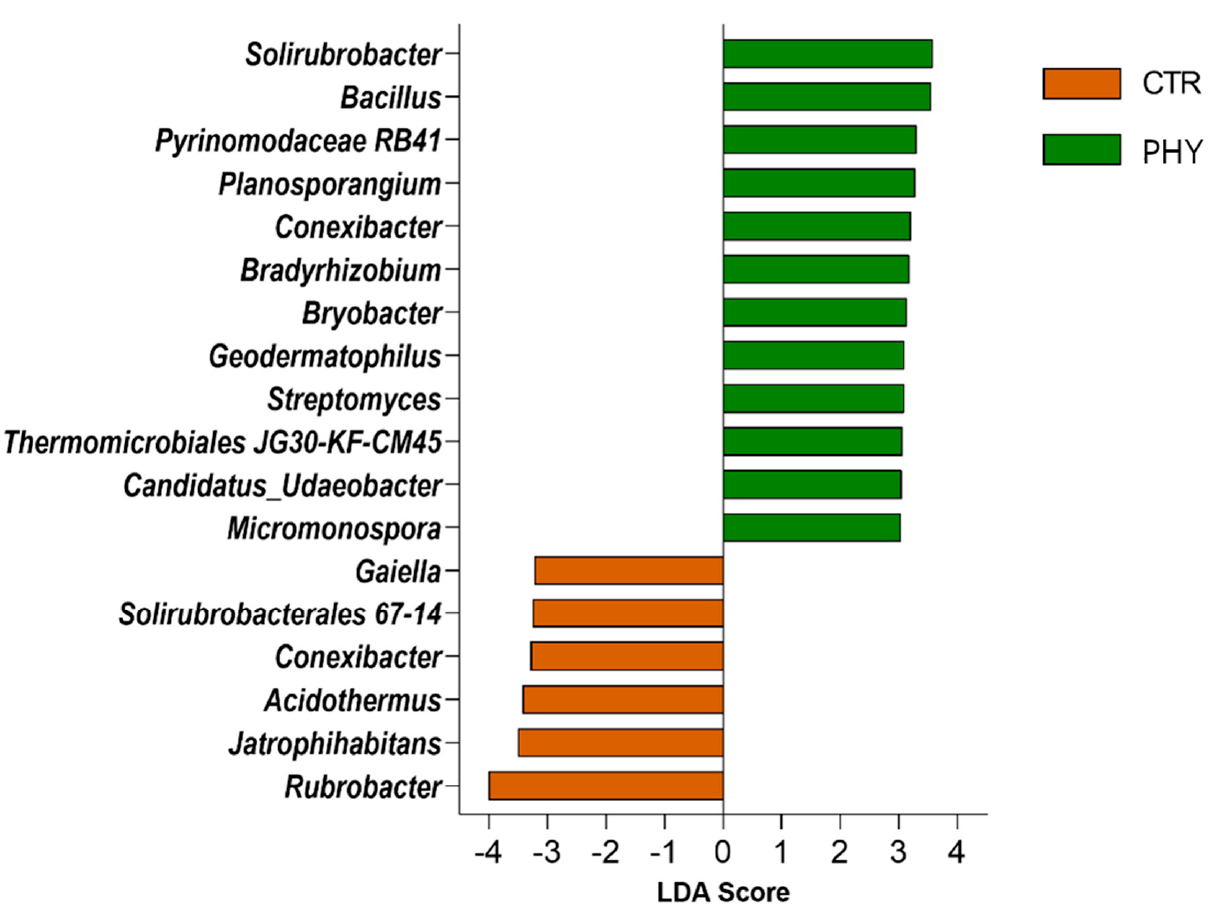
Figure 5. LEfSe plot at the genus level shows significantly altered ( p < 0.05) genera with an absolute LDA score > 3.